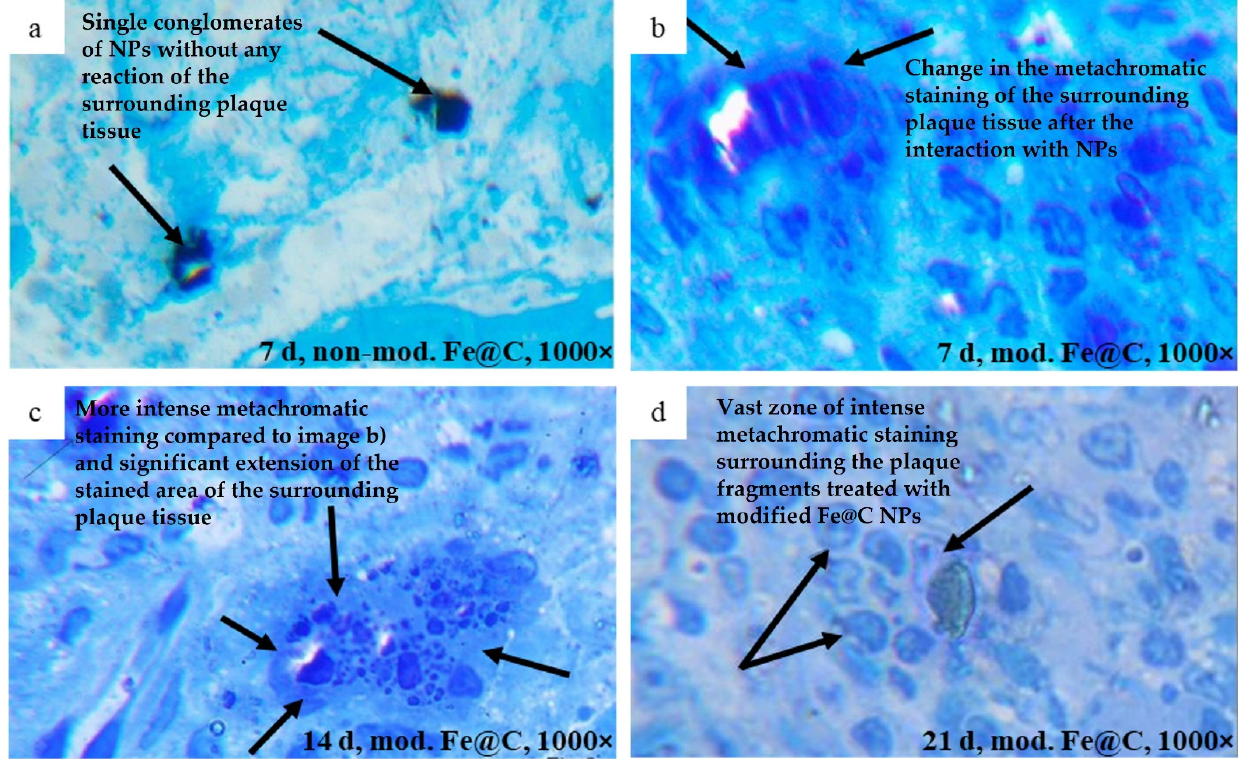
Figure 5. Histomorphological images of human atherosclerotic plaque tissue treated with: ( a ) non-modified Fe@C NPs after seven days subcutaneous implantation in rat; ( b ) modified Fe@C NPs after seven days implantation; ( c ) modified Fe@C NPs after 14 days implantation; ( d ) modified Fe@C NPs after 21 days implantation. The histological structures were obtained using light microscopy and studied in semi-thin sections, dyed with 1% solution of methylene blue with an optical magnification of 1000×. The arrows indicate sample areas, which were located in direct contact with Fe@C NPs and their agglomerates, respectively. Formation of dark blue tissue reaction zones in ( b – d ) indicated by arrows are present for modified Fe@C but not after contact of plaques with non-modified Fe@C NPs. Micrographs show expansion of these areas after 14 and 21 days of implantation (highlighted by arrows), indicating specific interaction of chemically modified Fe@C NPs with the structures of atherosclerotic plaques.